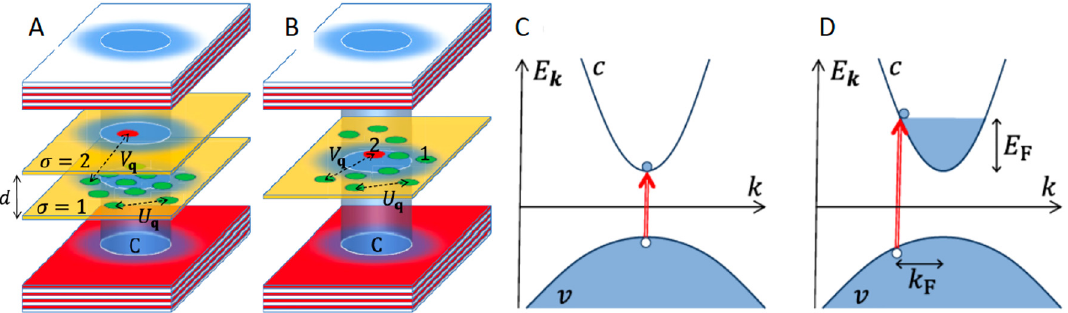
Figure 2: Charged exciton polaritons. Panel A: two quantum wells, labeled with the indicies σ = 1, 2 and separated by a distance d , form an electron – hole bilayer in the extremely imbalanced limit. The minority species belongs to the σ = 2 layer, while the majority species at σ = 1 forms an interacting Fermi sea. U q and V q are, respectively,intraspeciesandinterspeciesCoulombinteractions.Thebilayerislocated insideaplanarcavitythatcon fi nesthecavityphotonmode C.The(blue)shadedarearepresentsthe fi nite-sizeexternallaserpumpspot.PanelB:thesamesetupinasinglequantumwellgeometry.Here,the majority σ =1andminority σ =2speciesbelongtothesamewell.PanelsCandD:theparticle – holeexcitationprocessviaaphotonwithoutandwith Fermi sea, respectively. All photon-mediated transitions are approximately vertical in a cavity. Adapted from a study by Tiene et al.